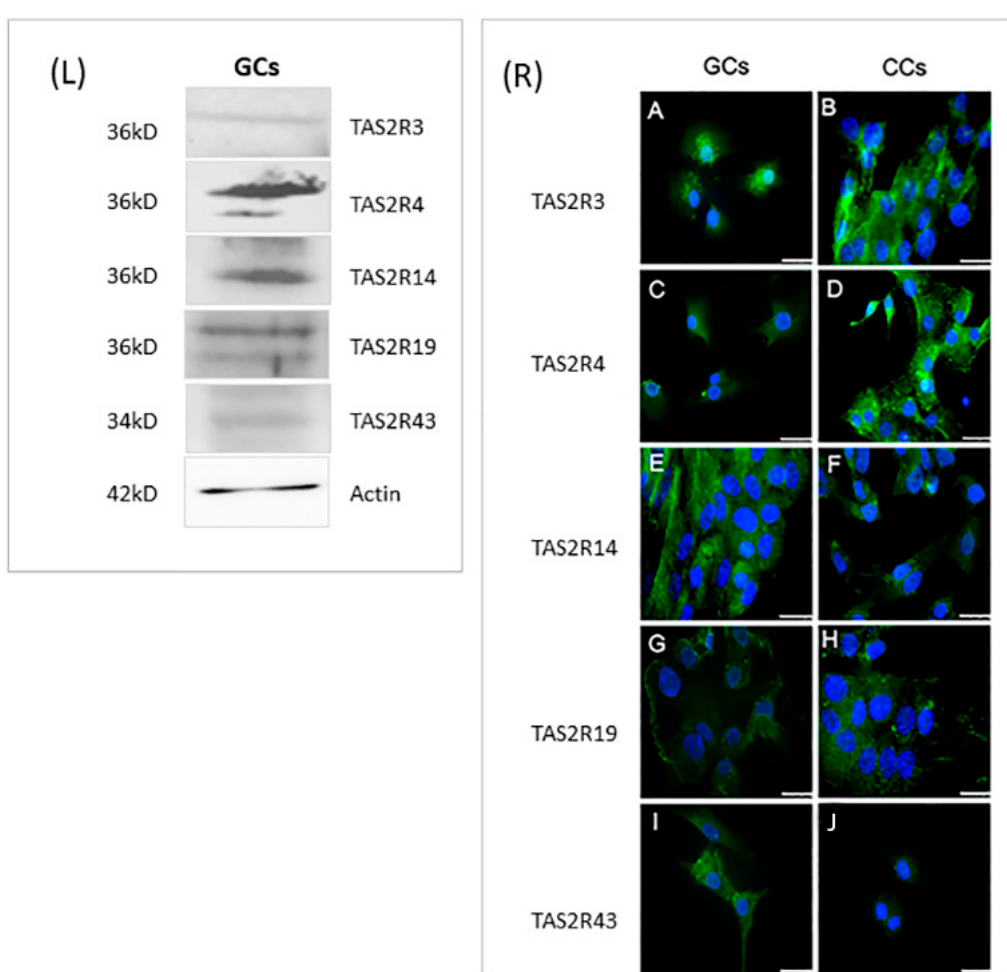
Figure 4. Left panel ( L ): Representative image of Western blot of TAS2R3, TAS2R4, TAS2R14, TAS2R19, and TAS2R43. β -actin was used as loading control. Right panel ( R ): Immunofluorescence localization of ( A , B ) TAS2R3, ( C , D ) TAS2R4, ( E , F ) TAS2R14, ( G , H ) TASR19, and ( I , J ) TAS2R43 in ( A , C , E , G , I ) granulosa and ( B , D , F , H , J ) cumulus cells. TAS2Rs are stained in green. Nuclei were counterstained with DAPI (blue). Scale bar = 15 μ m. Negative controls are shown in Figure S1.